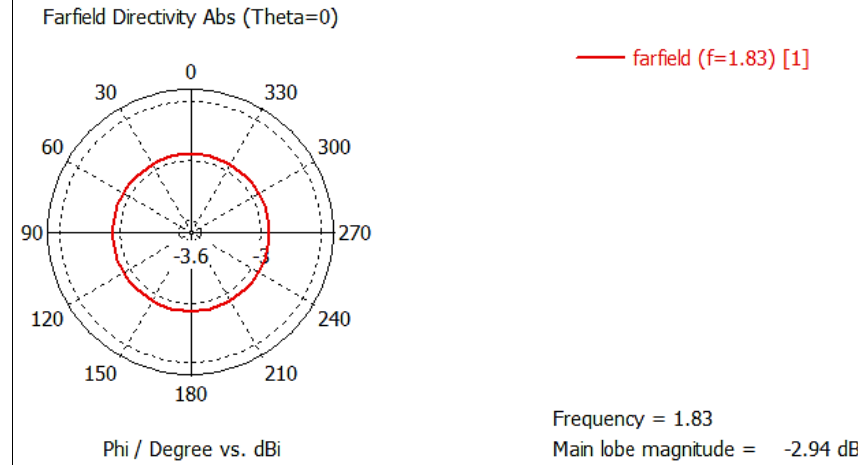
Figure 9. Antenna pattern at second frequency ( 𝑻𝒉𝒆𝒕𝒂 = 𝟎 )